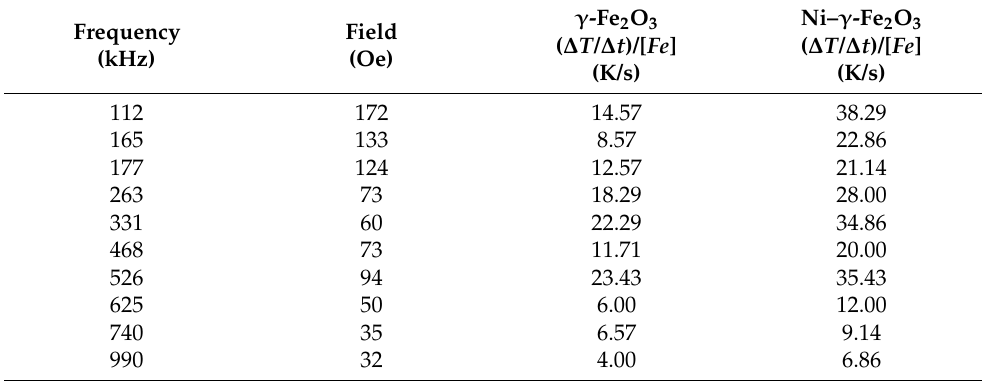
Table 4. Slope, ( ∆ T / ∆ t )/Fe, of the induction heating curve for H-USY(40) impregnated with γ -Fe 2 O 3 and Ni– γ -Fe 2 O 3 zeolites.